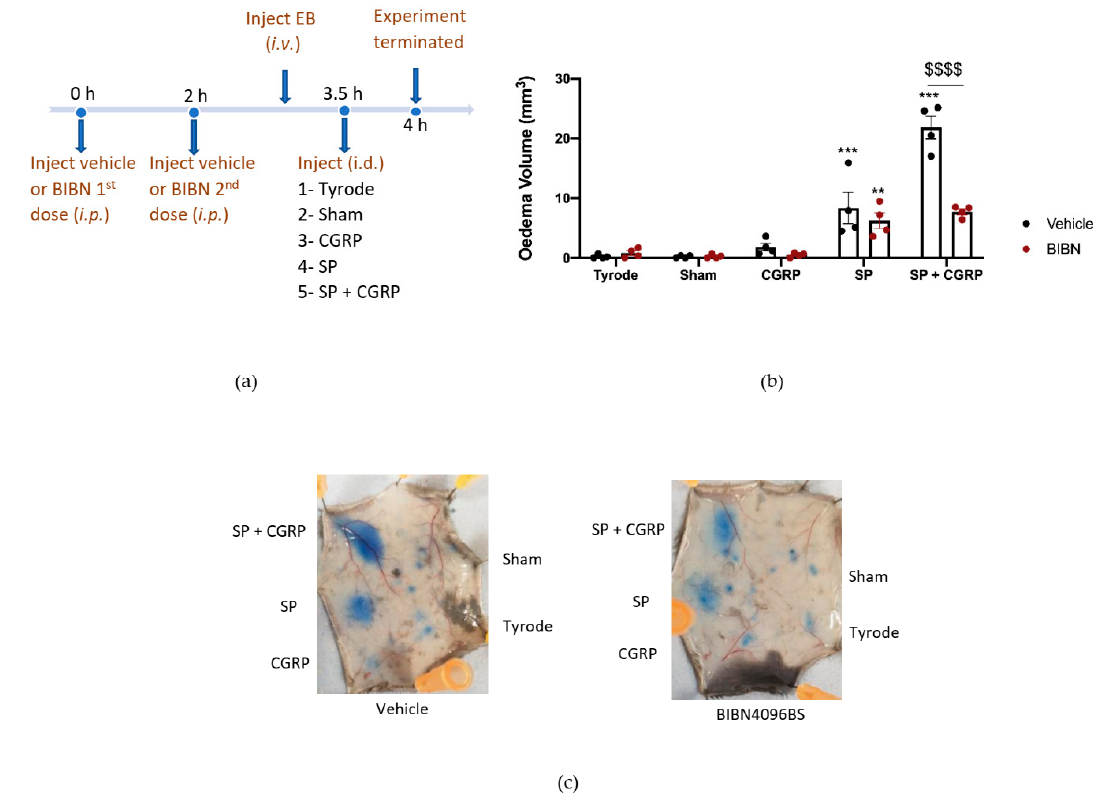
Figure 4. Characterisation of the Calcitonin gene-related peptide, CGRP, receptor antagonist, BIBN4096BS, and effect on oedema formation induced by SP + CGRP for 30 min after 3.5 h pre-treatment. ( a ) Timeline for studying the effect of the CGRP receptor antagonist BIBN4096BS (3 mg/kg i.p., given at − 0.5 h and at 2 h) over 4 h, on oedema formation induced by substance P (SP), CGRP, as well as SP + CGRP over 30 min. ( b ) Oedema volume measured after injecting SP (300 pmol/50 µ L) ± CGRP (20 pmol/50 µ L i.d.) for the last 30 min of the protocol in vehicle or BIBN4096BS pre-treated mice. ( c ) Representative images. Results are shown as mean ± SEM ( n = 4). Two-way ANOVA with Bonferroni’s post hoc test. ** p < 0.01 and *** p < 0.001 are compared to Tyrode. $$$$ p <0.0001 is compared to Vehicle SP + CGRP.